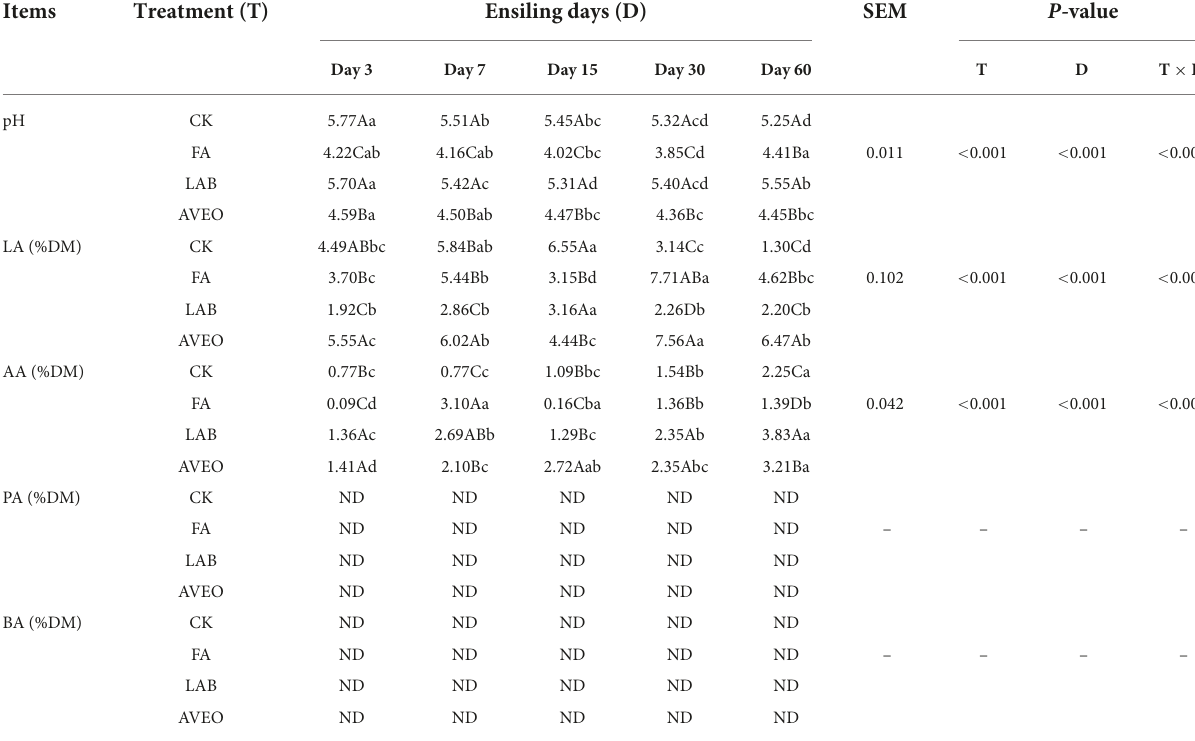
TABLE 2 Fermentation quality of paper mulberry silage.